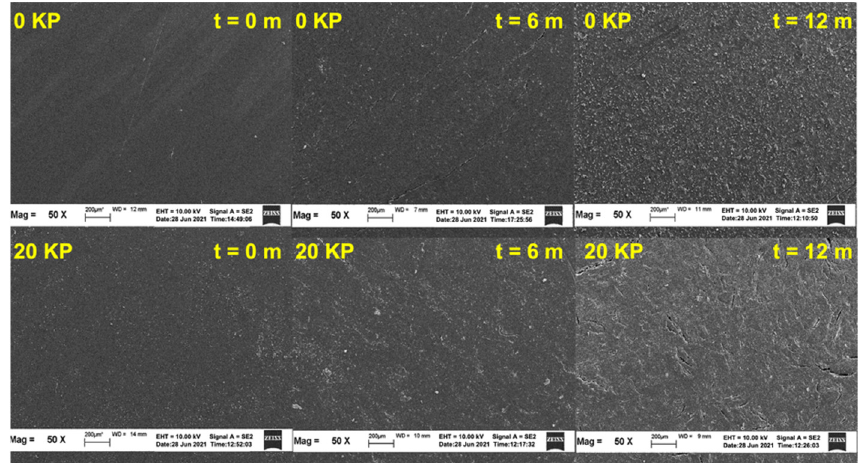
Figure 9. SEM micrographs at 50× magnification of KP-filled rHDPE/NR blends before and after 6 and 12 months of natural weathering.